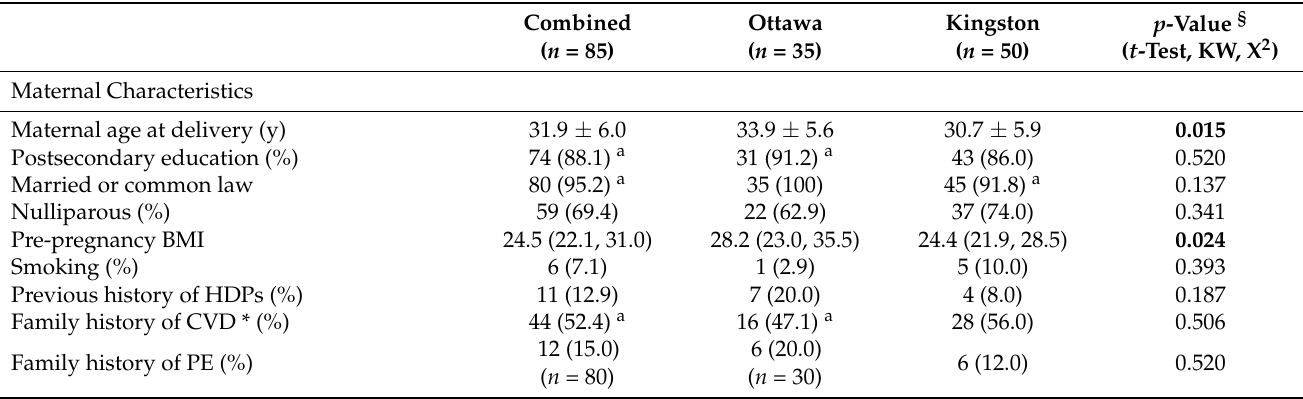
Table 1. Maternal characteristics of the study participants as a combined cohort and by individual study site.